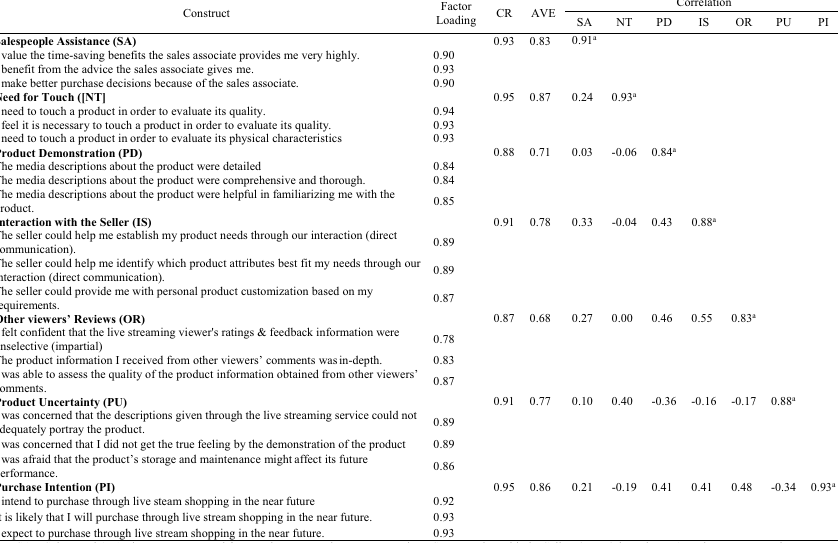
Construct Factor Loading CR